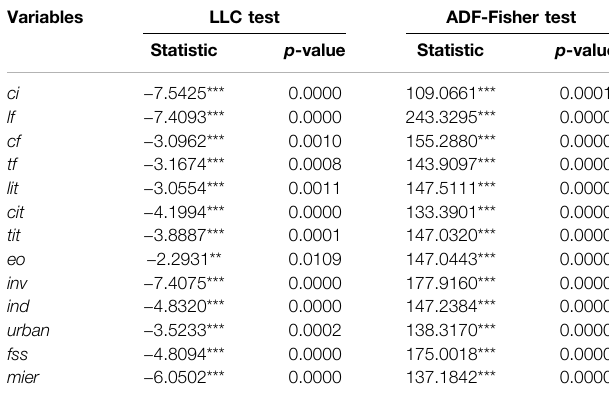
TABLE 2 | Results of the panel unit root